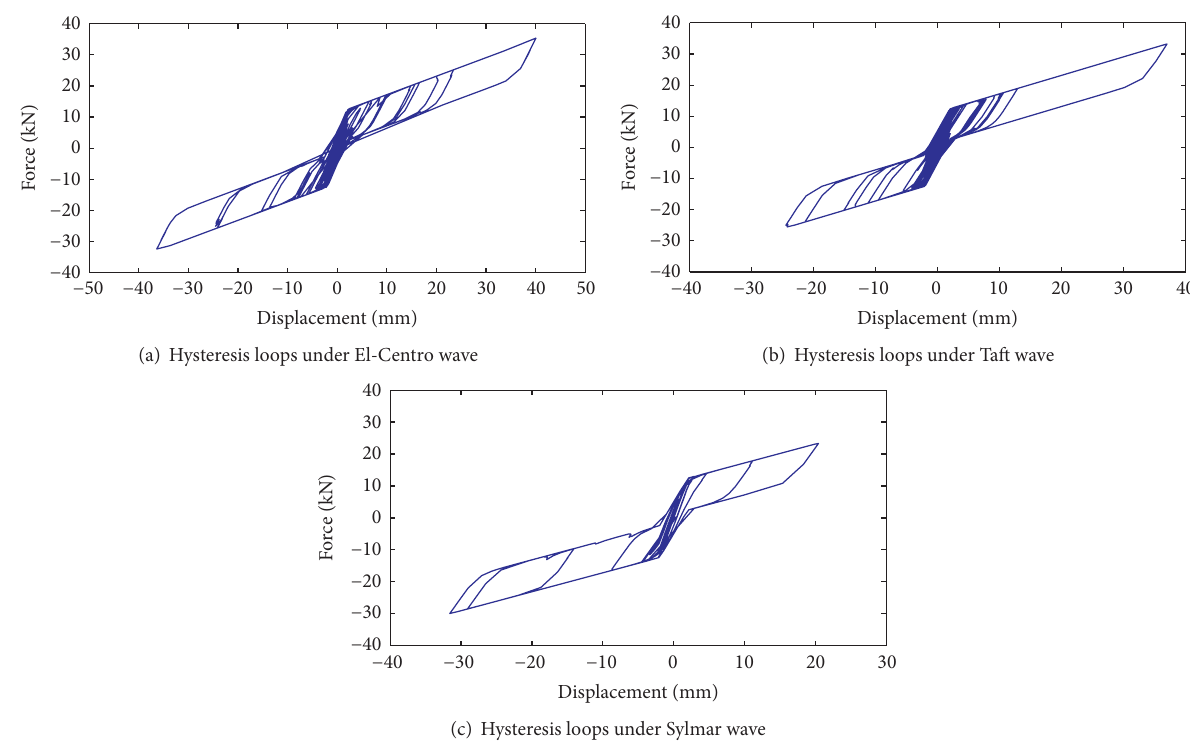
Figure 13: Force-displacement curves of the SMA spring restrainer under various earthquake wave (PGA = 0.4g). Table 4: Control effect of peak axial force under seismic excitations scaled to 0.2 g amplitude (units in kN). Beam number